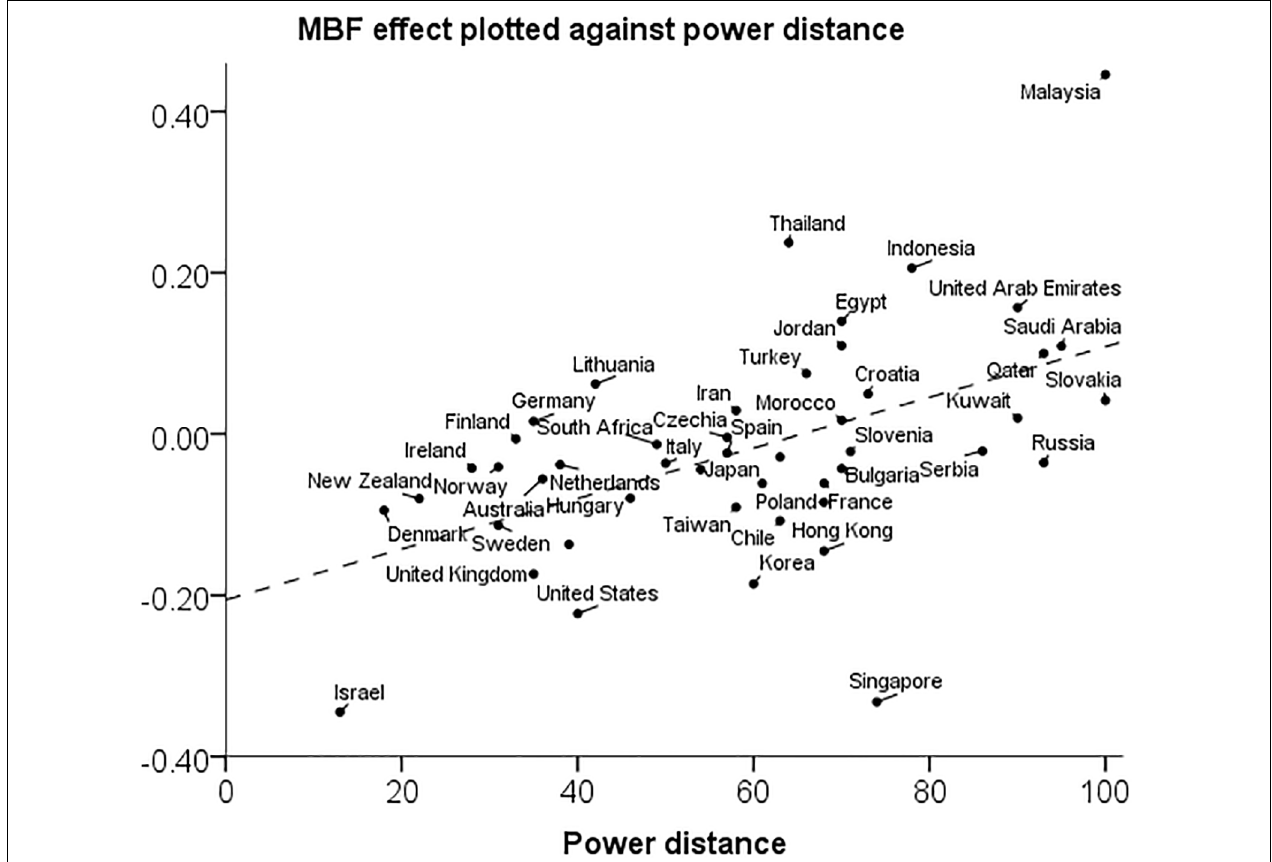
FIGURE 2 | Scatter plot of the aggregate controlled MBF effect against power distance in 47